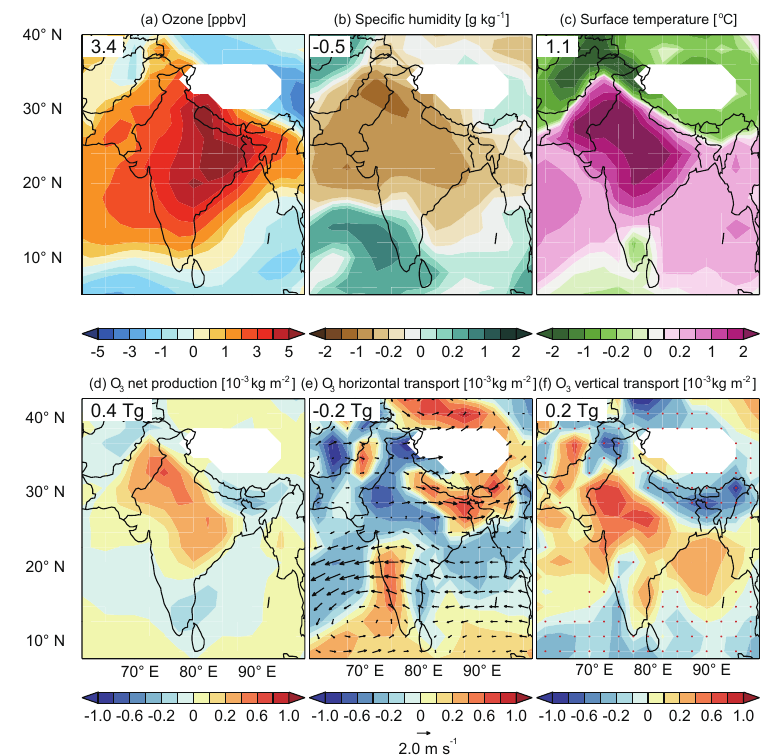
Figure 8. Differences in May–August monthly mean (a) lower tropospheric ozone concentration, (b) surface temperature, (c) 850hPa specific humidity, (d) lower tropospheric net ozone production, (e) lower tropospheric net horizontal transport with wind vectors overlaid, and (f) vertical transport at 600hPa between the lowest and highest SASMI conditions. Values are calculated using averages of the five lowest SASMI years minus averages of the five highest SASMI years. Values inset are averages (a–c) or totals (d–f) over the Indian terrestrial land. Red dots in (f) denote regions with stronger air uplift in weak compared to strong summer monsoon